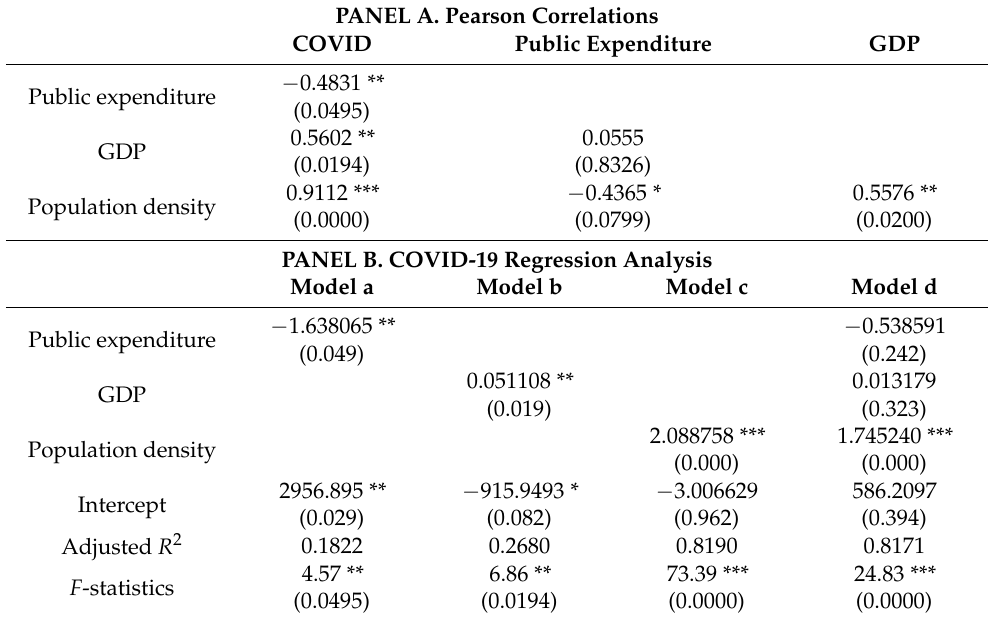
Table 6. Determinants in the frequency of COVID-19 cases.